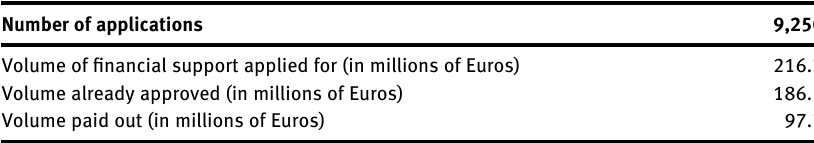
Table  : State of applications for the federal nonpro fi t fund by end of September  . Number of applications  ,  Volume of fi nancial support applied for (in millions of Euros)  .  Volume already approved (in millions of Euros)  .  Volume paid out (in millions of Euros)  .  (Source: Austrian Parliament 